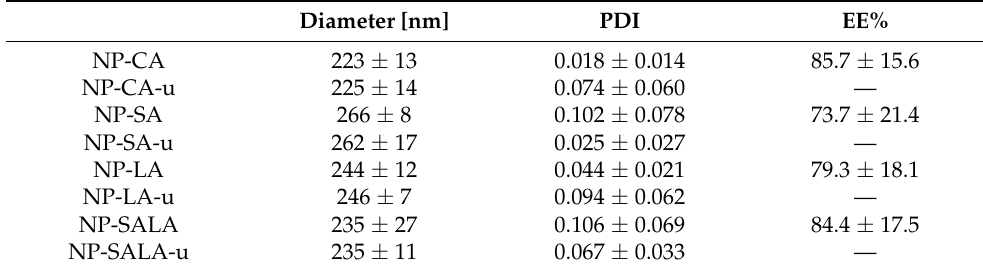
Table 1. Nanoparticle size and entrapment efficiency EE%. Diameter